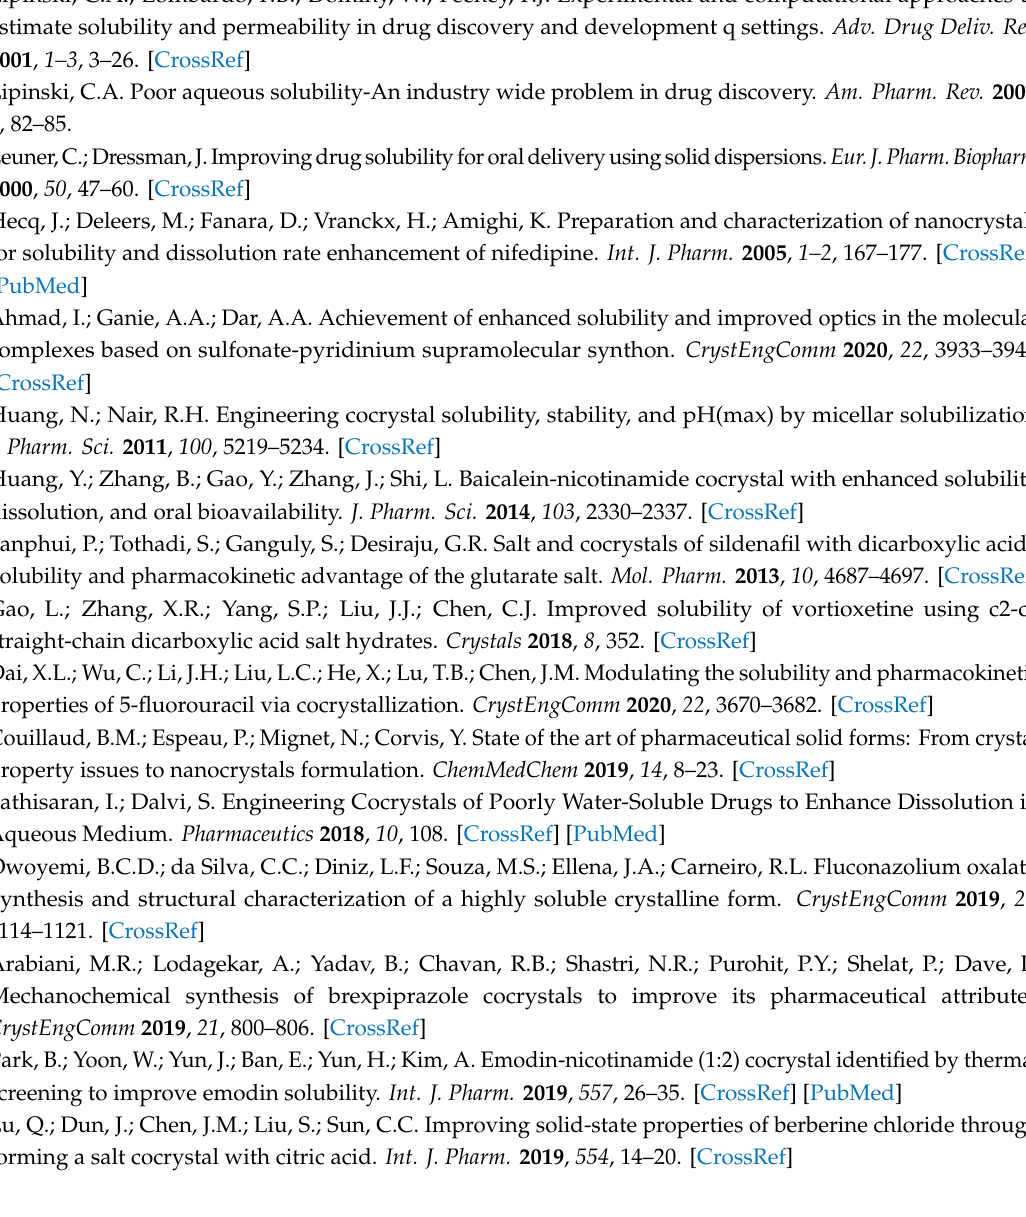
25 ◦ C under various RH conditions for 14 days, Figure S10: PXRD profiles for SAF-HCl salt after storage at 25 ◦ C under various RH conditions for 14 days, Figure S11: PXRD profiles for SAF-HBr salt after storage at 25 ◦ C under various RH conditions for 14 days, Figure S12: PXRD profiles for SAF-MA-H2O salt after storage at 25 ◦ C under various RH conditions for 14 days, Figure S13: PXRD profiles for SAF-MA after storage at 25 ◦ C under various RH conditions for 14 days. Crystallographic data, deposition number 2010646-2010649, were deposited with the Cambridge Crystallographic Data Centre. These data can be obtained free of charge from the Cambridge Crystallographic Data Centre via www.ccdc.cam.ac.uk /